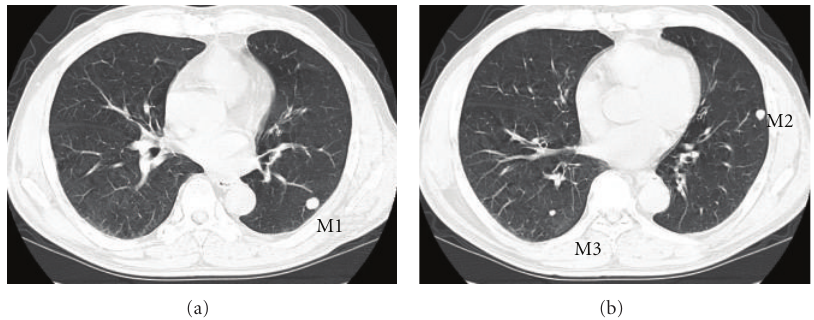
Figure 5: Ten weeks after the first operation. (a), (b) Development of multiple lung metastases (M1, M2, M3).